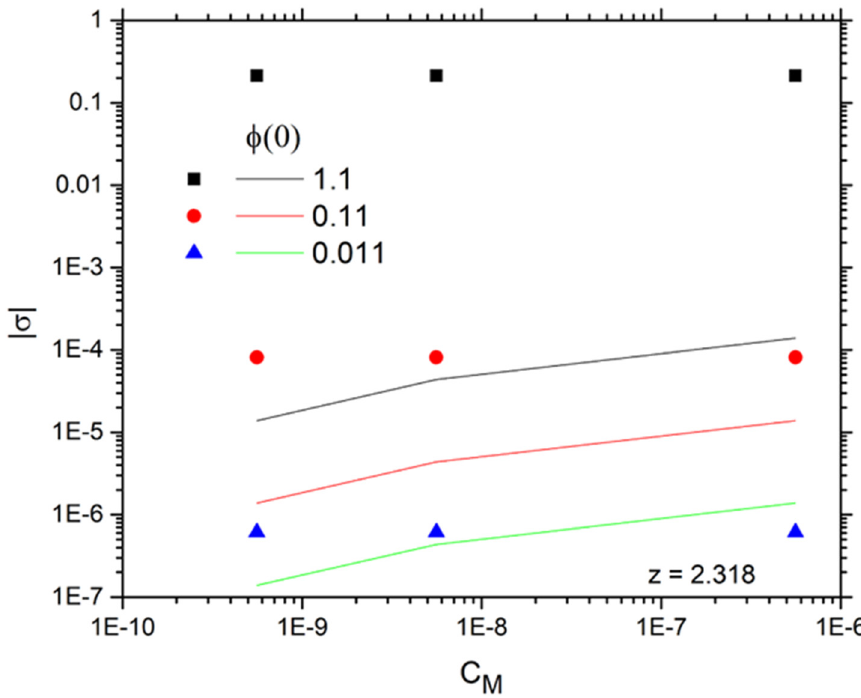
Figure 5. Surface charge density | σ | ( C / m 2 ) as a function of C M ( mol / m 3 ) for toxin 1 ( Staphylococcus aureus alpha-hemolysin) for various electric potentials ϕ ( 0 ) ( V ) (discrete points). Solid lines represent the corresponding | σ l | values.